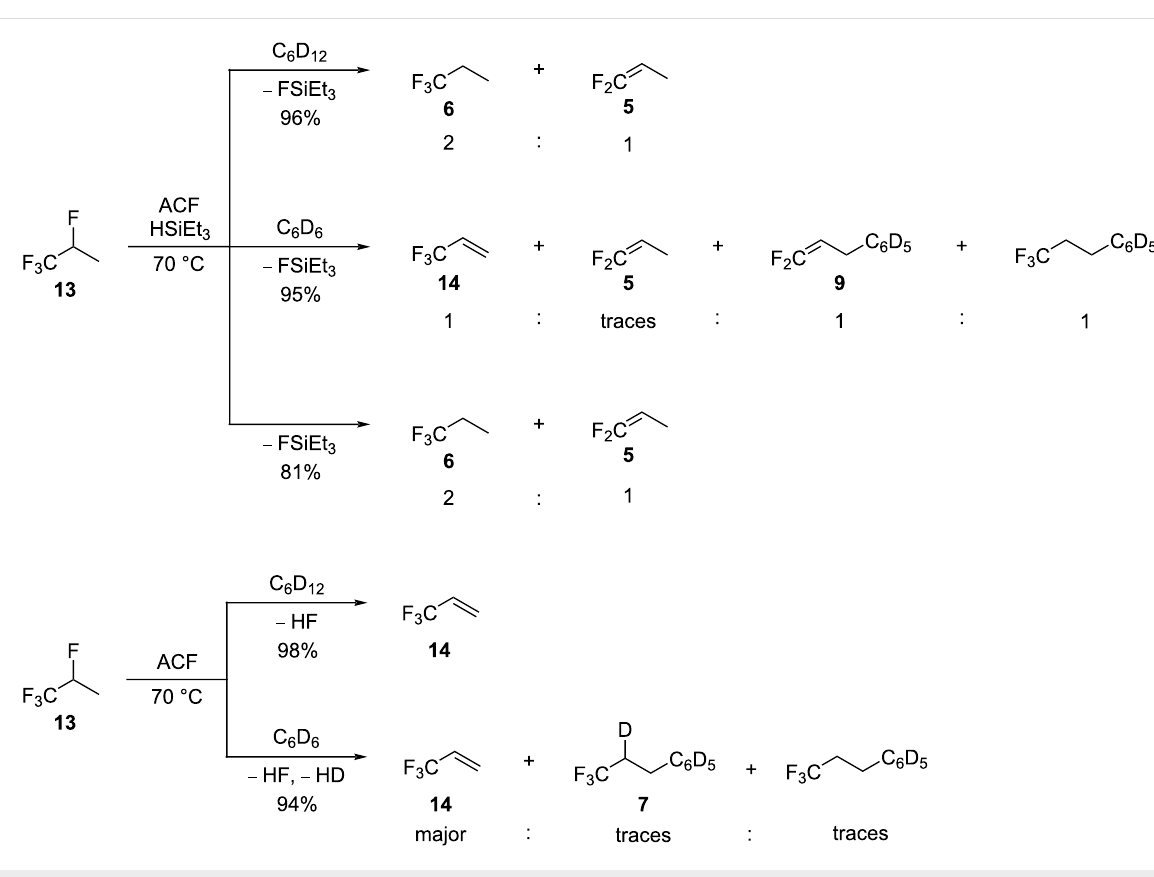
as a solvent in the presence of silane, 5 , 14 , 9 , and the Friedel–Crafts product CF 3 CH 2 CH 2 C 6 D 5 were generated.